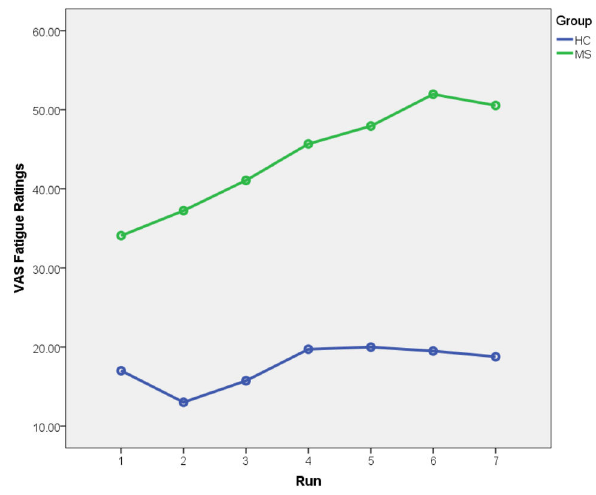
Figure 2. Fatigue across run for MS and HC group. Experiment 1: Results of group (2) x run (7) mixed design ANCOVA (age as covariate) examining